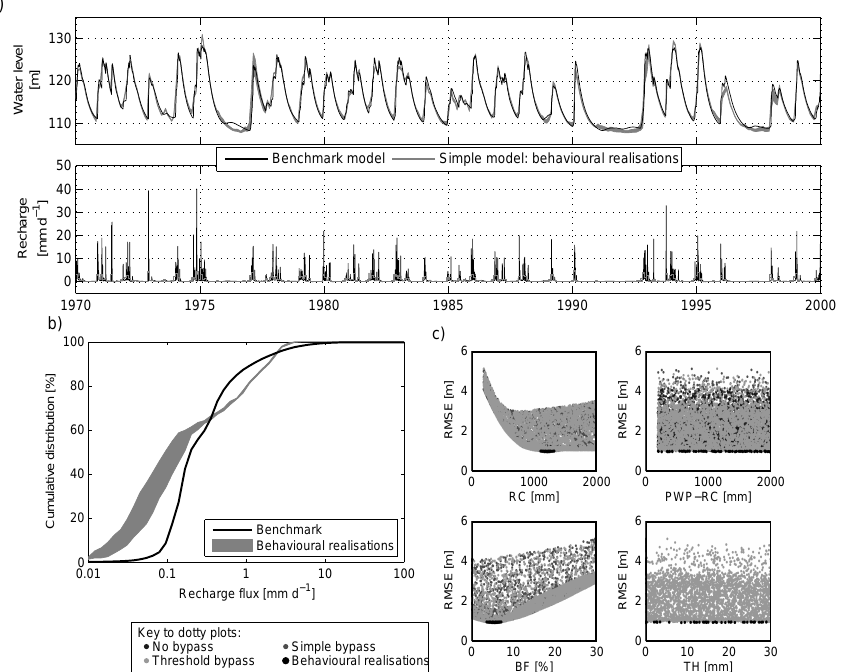
Fig. 8. Results from the simple model using a monthly time step . (a) Performance of the simple model (grey lines) in reproducing benchmark (black lines) water table, recharge, soil moisture status and actual evaporation; (b) cumulative distribution of recharge fluxes; (c) parameter